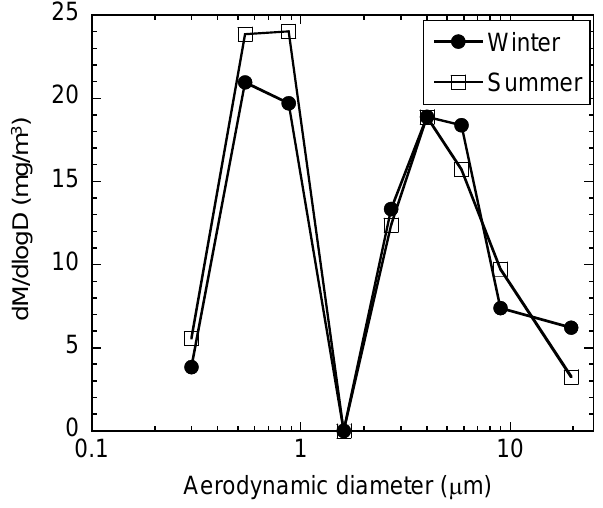
Fig. 1. Size distribution of the aerosol mass during winter (21 Jan- uary to 12 February 2002) and summer (28 July to 13 August 2002) at Tsukuba,